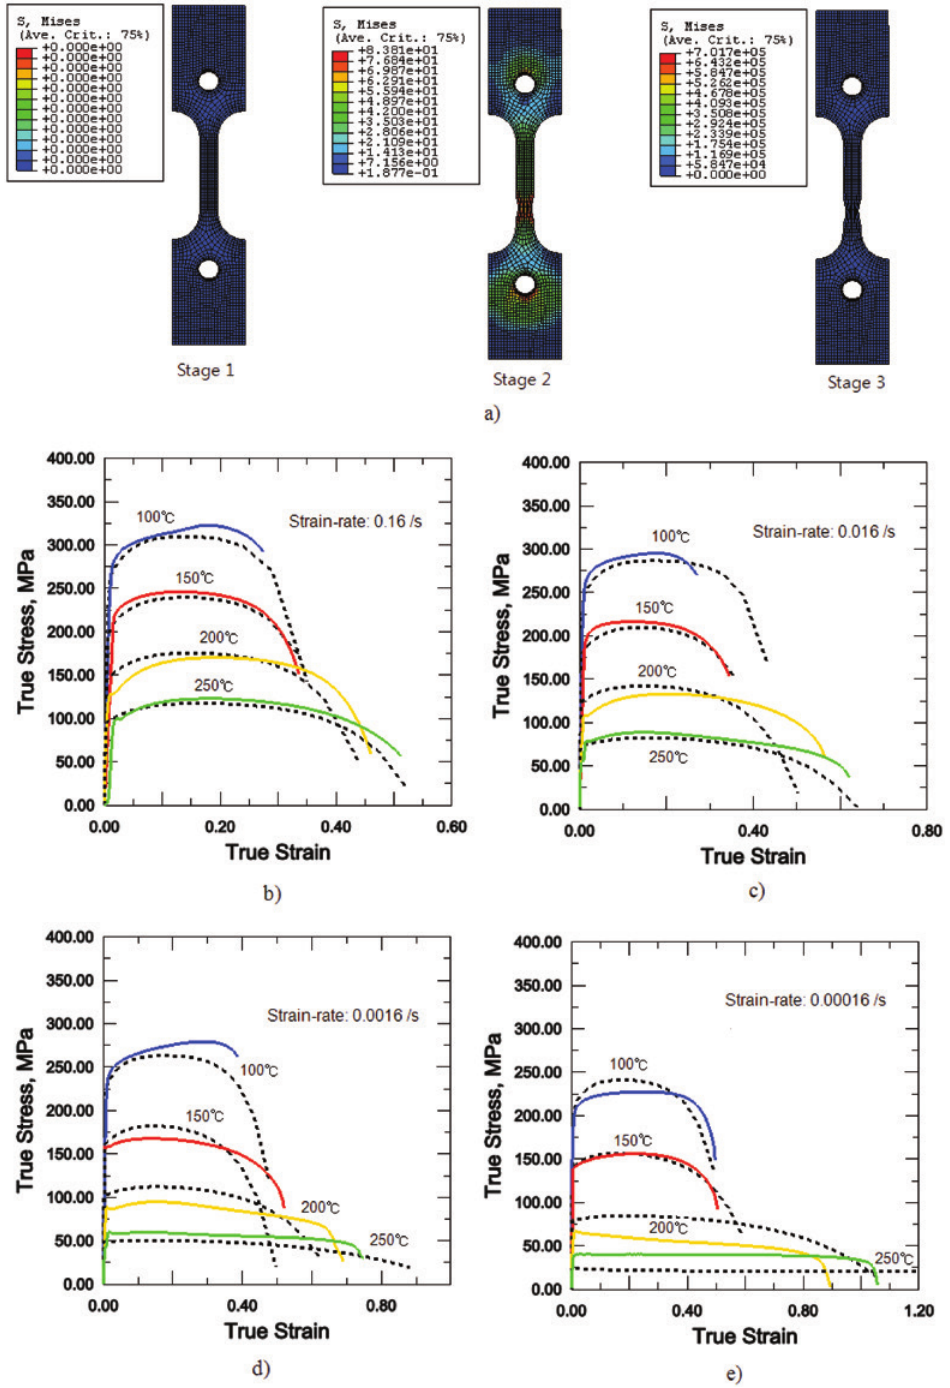
Fig. 6: (a) Tensile deformed shape and (b)–(e) comparison between simulation and experimental flow stress curves at elevated temperatures and strain rates 0.16/s, 0.016/s, 0.0016/s,